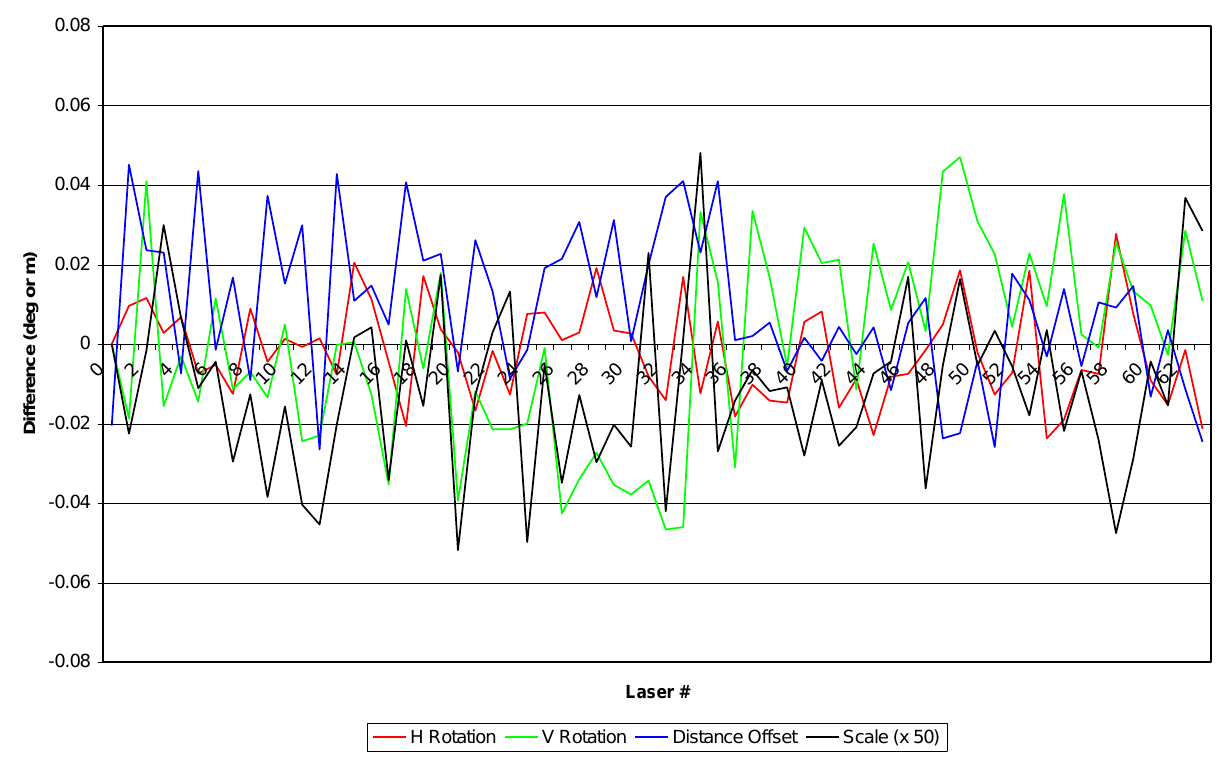
Figure 6. Temporal Calibration Differences Between Observations Sets for Laser 2. Laser 2 - Temporal Calibration